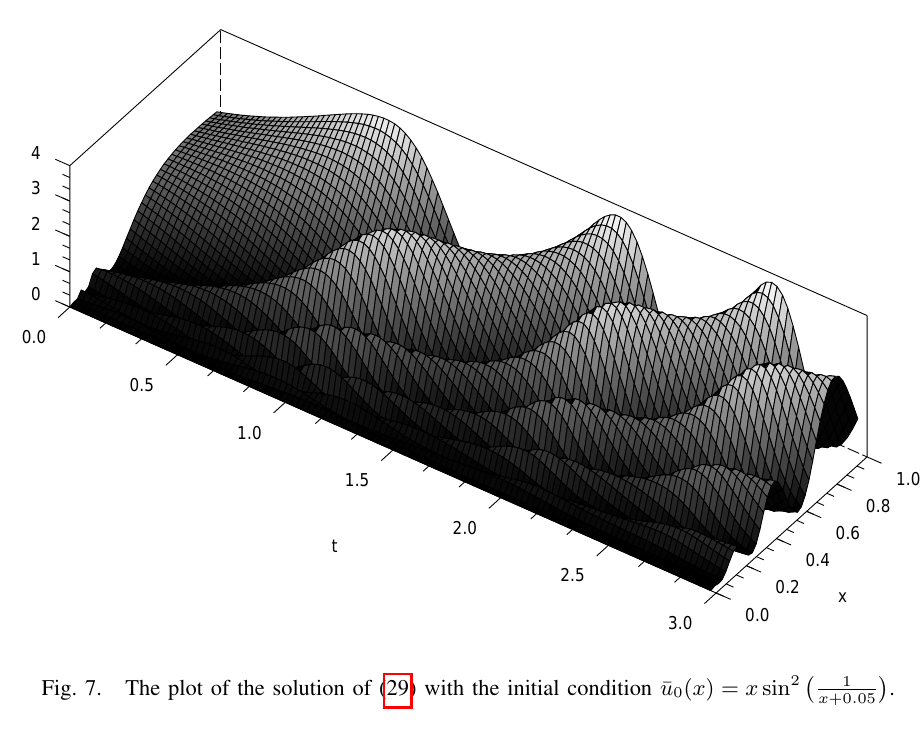
(cid:1) in the time interval [0 , 3] . x